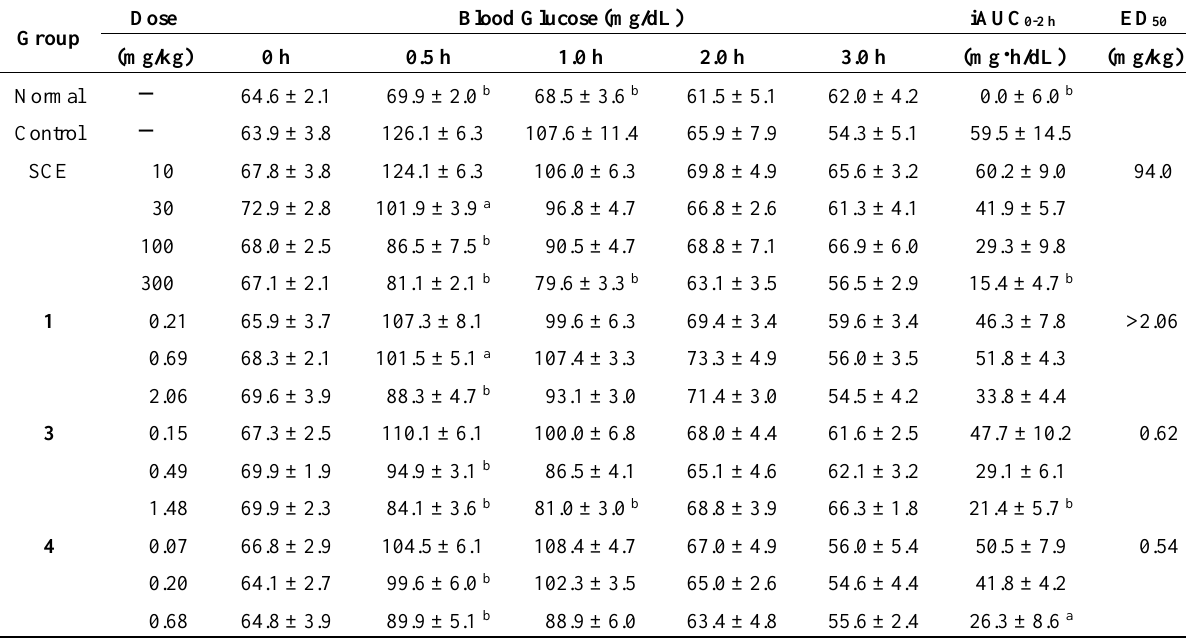
Table 2. Effects of a hot water extract of stems of Salacia chinensis (SCE) and principal sulfoniums ( 1 , 3 , and 4 ) on blood glucose levels in starch-loaded rats.